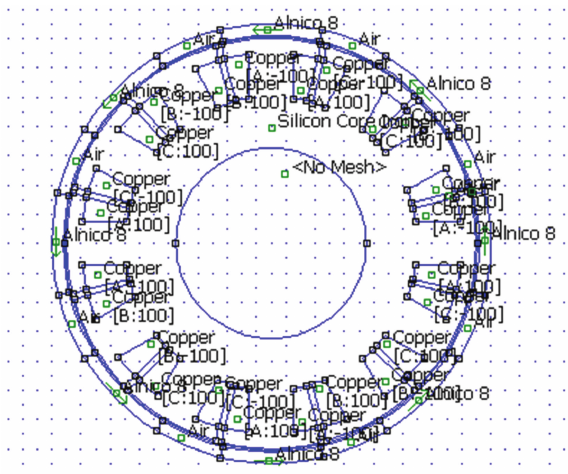
Figure 1: Motor model.